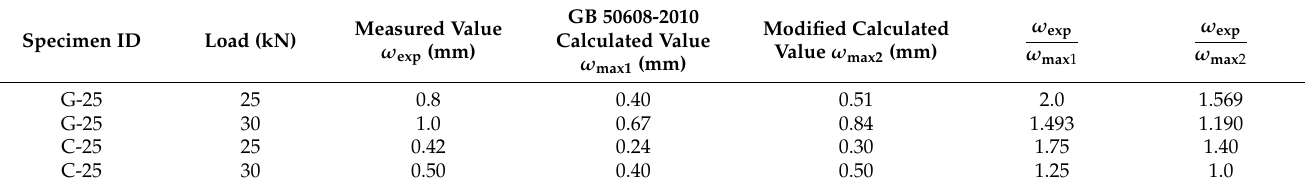
Table 5. Comparison between measured and calculated values of maximum crack width of tested beam specimens at room